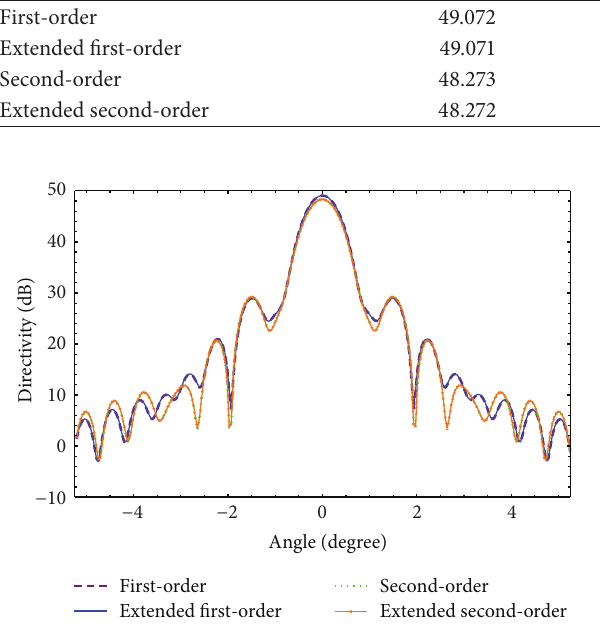
Figure 5: Far field pattern comparisons of the extended formula with the previous one under deformation (15).